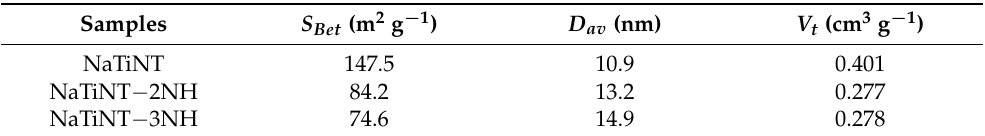
Table 1. TNitrogen adsorption-desorption analysis of samples, surface area (BET), diameter and volume of